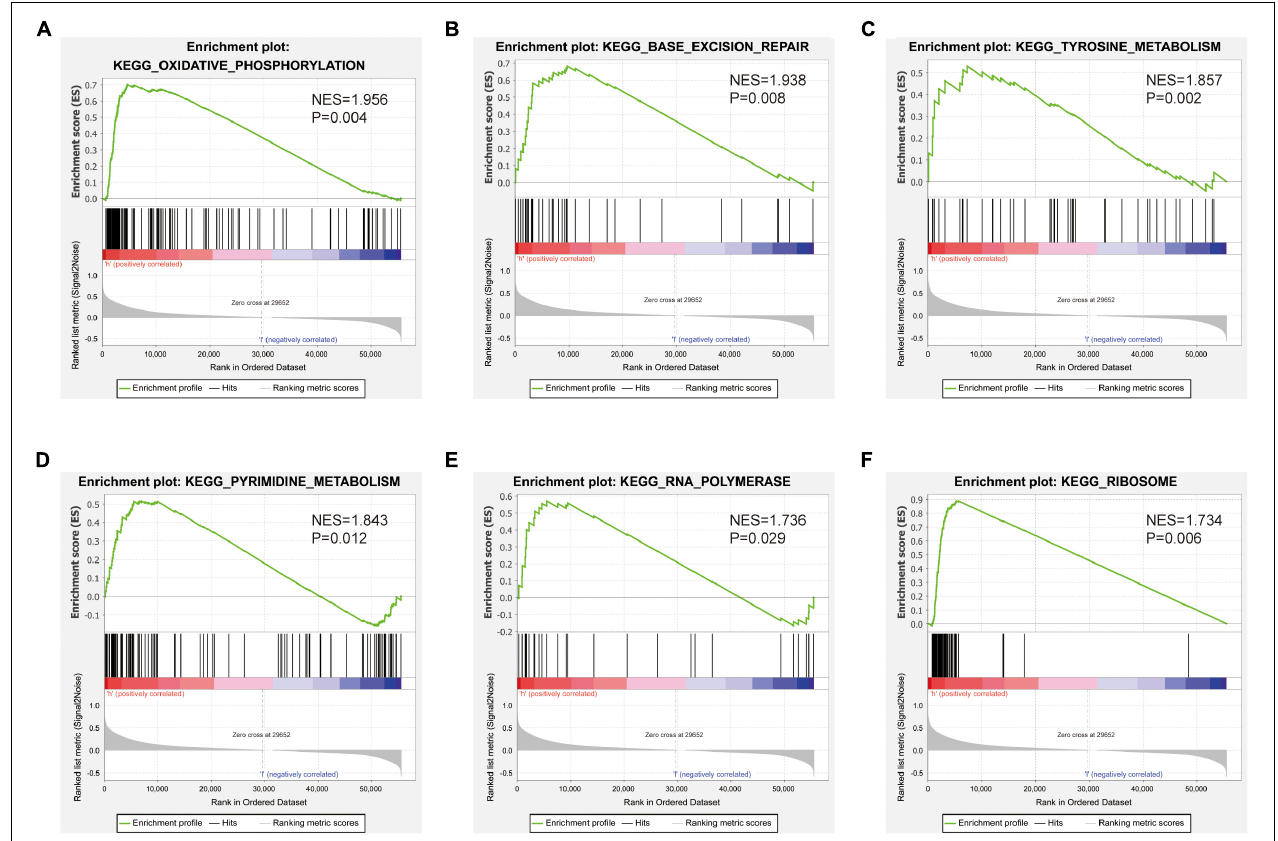
FIGURE 8 | Pathways involved in the pathogenesis of SNHG10 from the GSEA. Enrichment plots comparing SNHG10 expression in terms of (A) oxidative phosphorylation, (B) base excision repair, (C) tyrosine metabolism, (D) pyrimidine metabolism, (E) RNA polymerase, and (F)